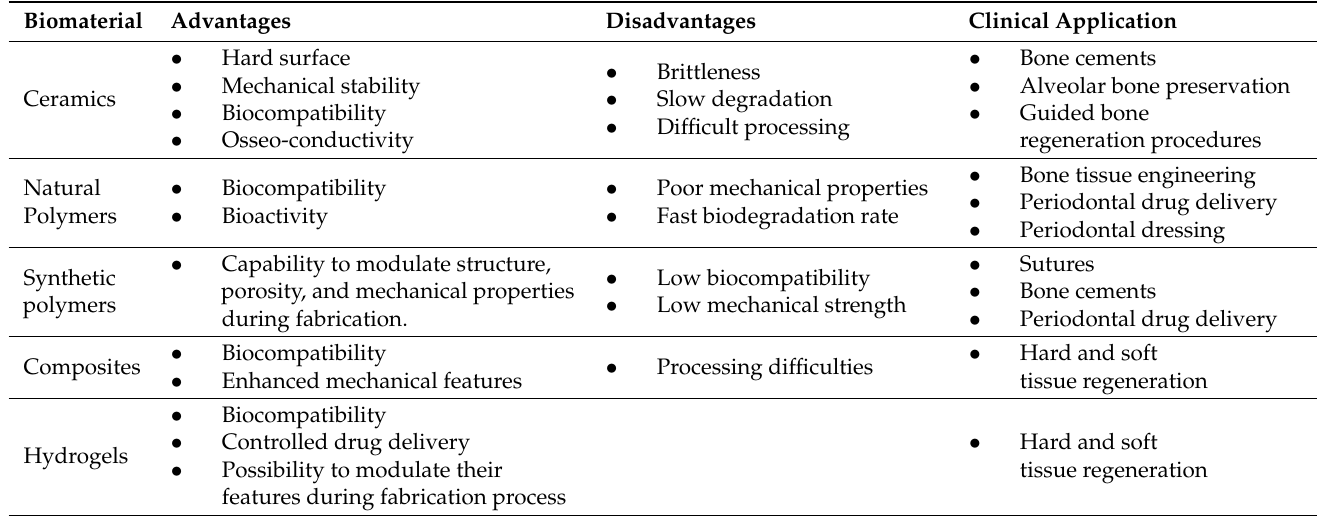
Table 1. Biomaterials’ benefits, drawbacks, and therapeutic